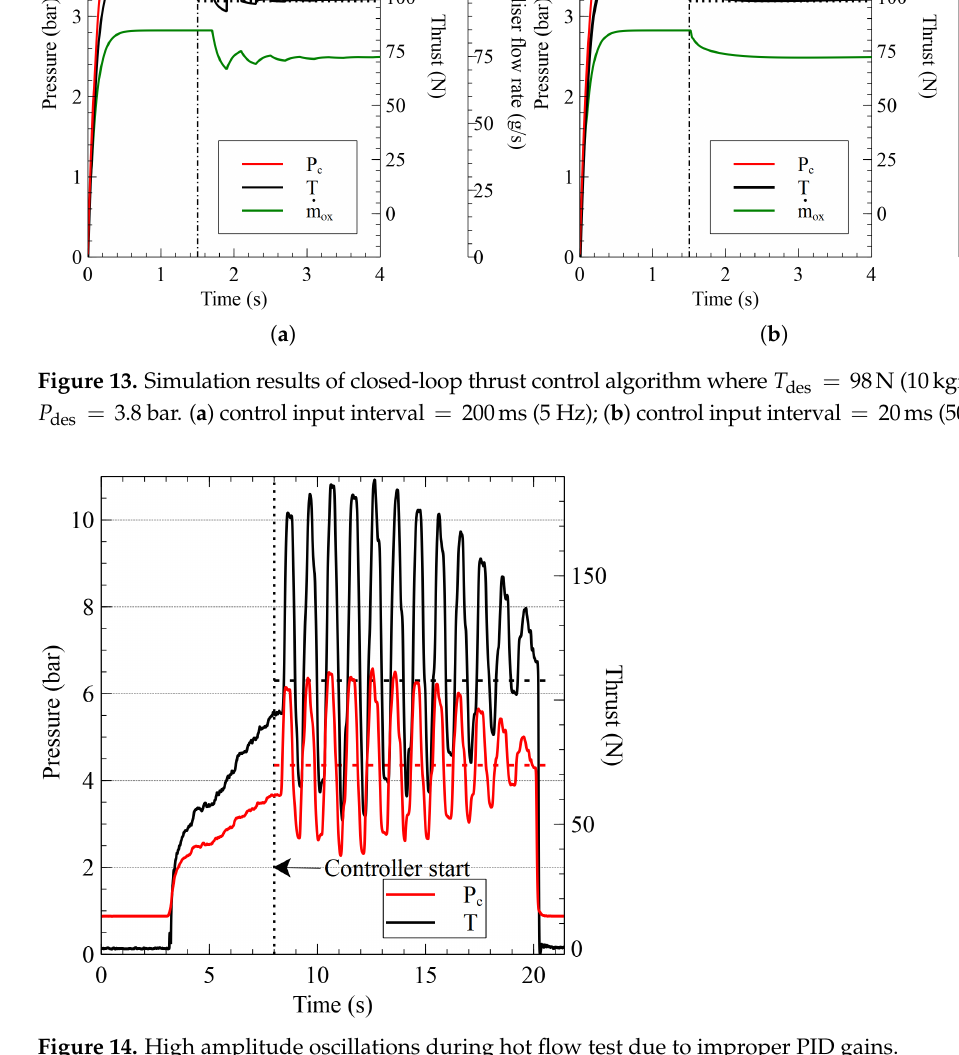
Figure 14. High amplitude oscillations during hot flow test due to improper PID